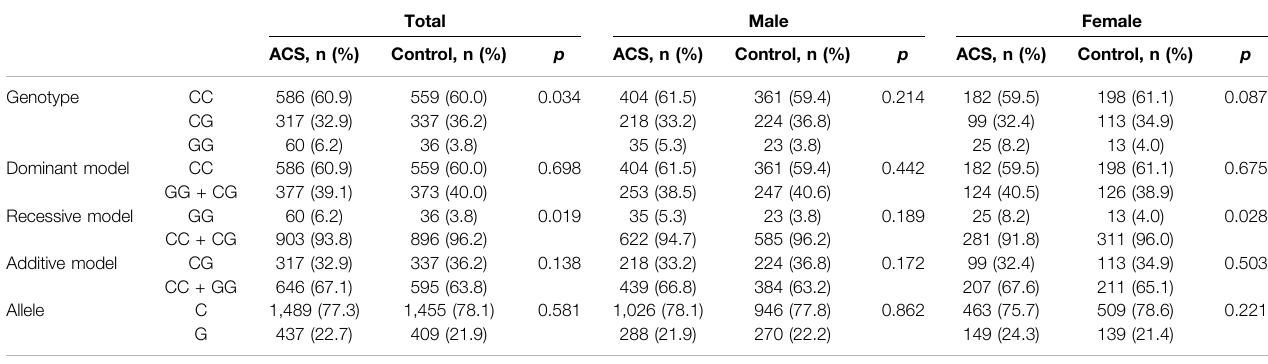
ACS, acute coronary syndromes.